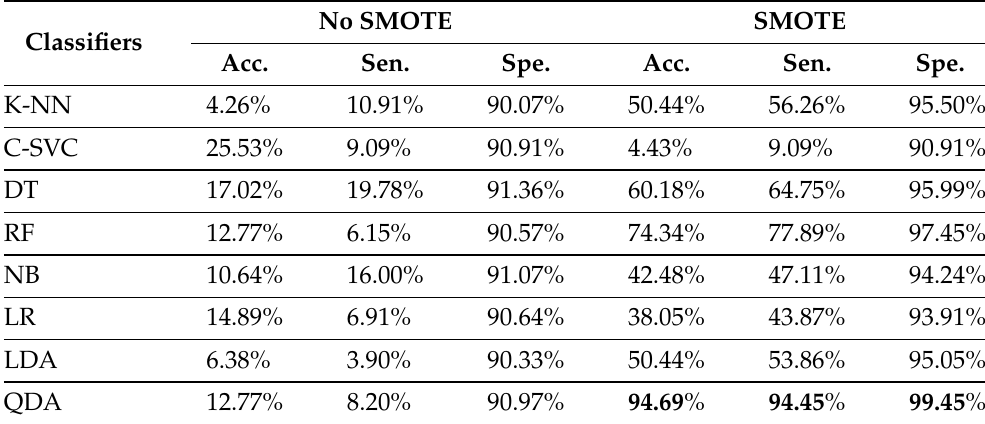
Table 1. Machine-learning Accuracy (Acc.). Sensitivity (Sen.) and Specificity (Spe.) with and without